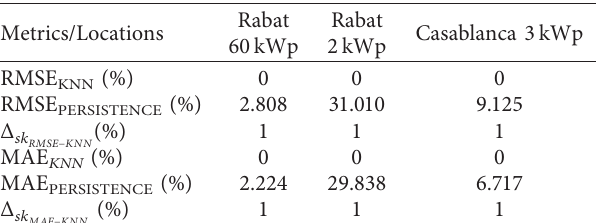
Table 11: Summary results of assessment of accuracy of KNN forecast model for each